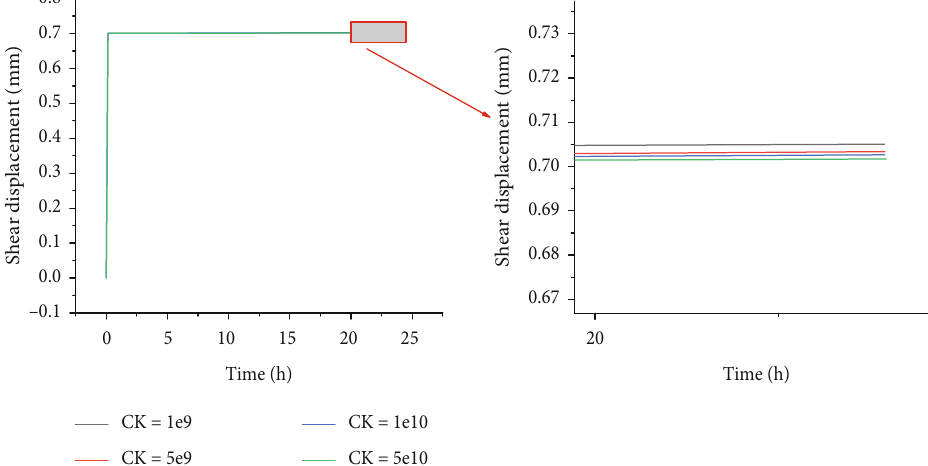
Figure 10: Shear displacement-time relation under di ff erent C